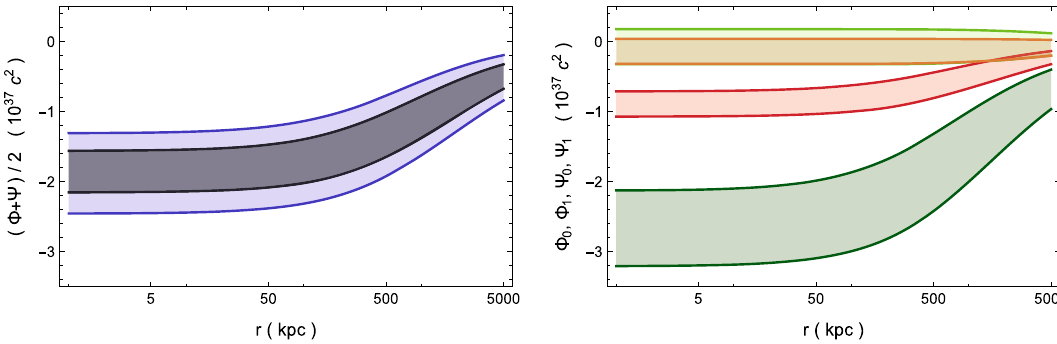
Fig. 2 Gravitational lensing potential (dimensionless) contributions for A611. Left panel: total gravitational potential for GR (black) and nonlocal (blue). Right panel: Φ( r ) (green) and Ψ( r ) (red) contributions; zeroth-order terms are in dark colors, first-order terms are in light